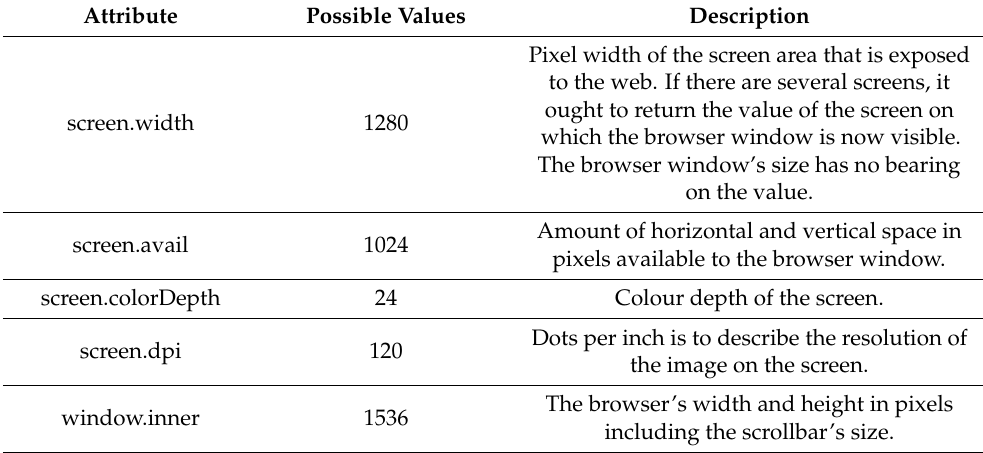
Table 5. Example of screen and window attributes